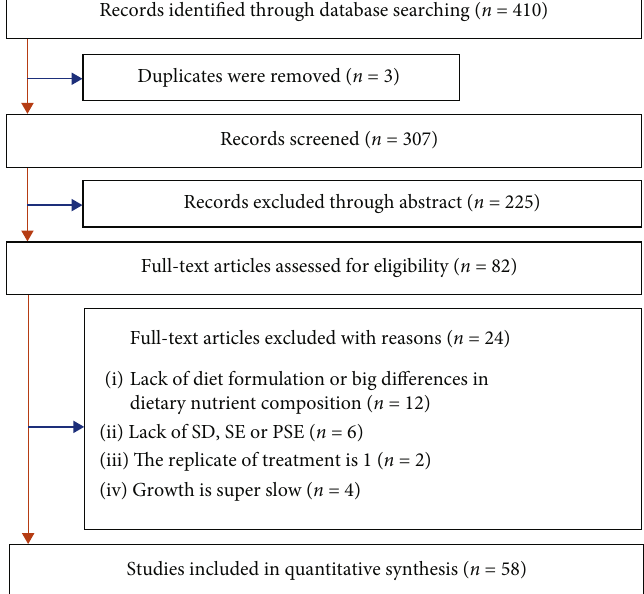
Figure 1: Flow diagram of eligible study selection according to Preferred Reporting Items for Systematic Reviews and Meta-Analyses (PRISMA). The SD, SE, and PSE represented standard deviation, standard error, and pooled standard error,